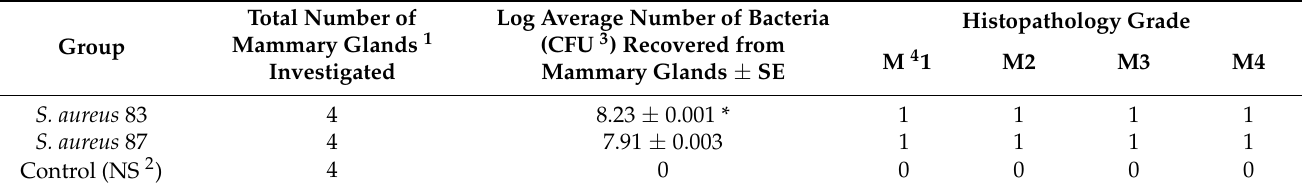
Table 3. Total viable counts of NT S. aureus recovered from mammary glands after death of mice and histopathology of mammary glands.